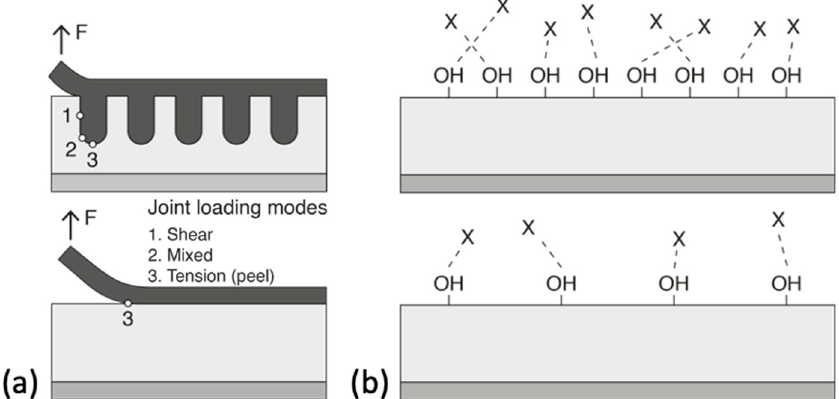
Figure 4. Schematic illustrations of the ( a ) mechanical advantage provided by surface treatments that increase the surface roughness and bonding area and ( b ) the effect of hydroxyl density on interfacial bonding with adhesive (represented by X). Reprinted with adjustments from [121] http://creativecommons.org/licenses/by/4.0/.